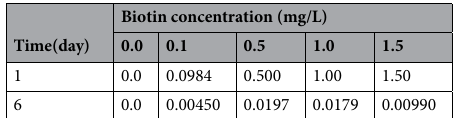
Table 2. Biotin concentrations during the cultivation process in the experimental system.